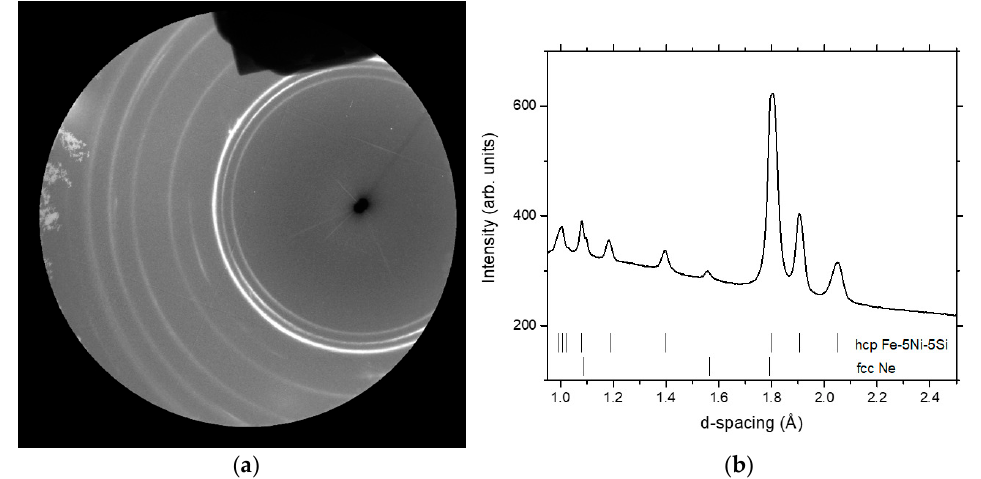
Figure 1. Example of the collected data at high pressure and ambient temperature. ( a ) 2D diffraction image and ( b ) integrated diffraction pattern of Fe–5Ni–5Si at 55.7 GPa.